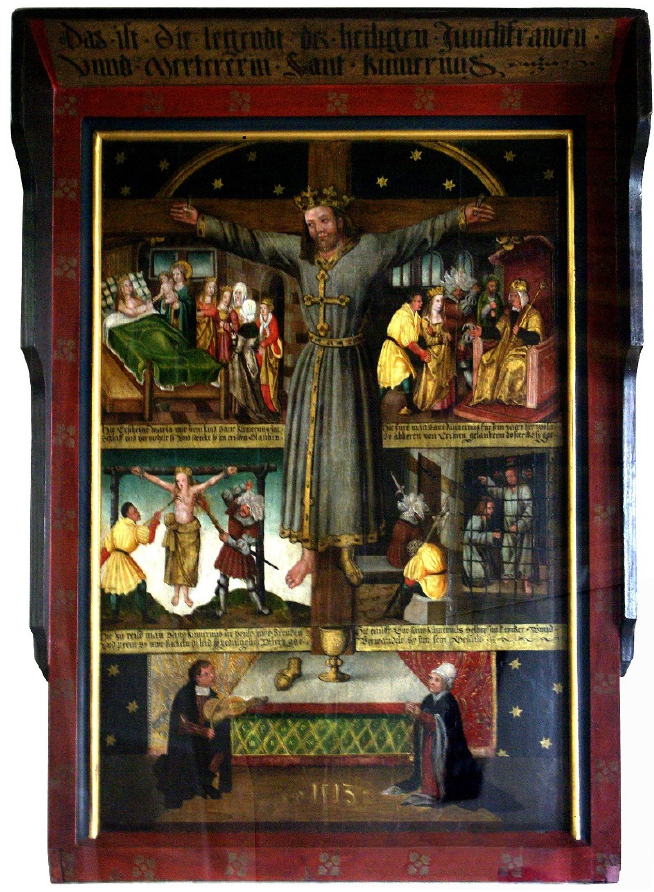
Figure 5. Kümmernis (1513), Egidienkirche, Erlangen-Eltersdorf. Photo Credit: Unknown author, Fotografie des Gemäldes, Public Domain, https://commons.wikimedia.org/w/index.php?curid=7763933 (accessed on May 2022).